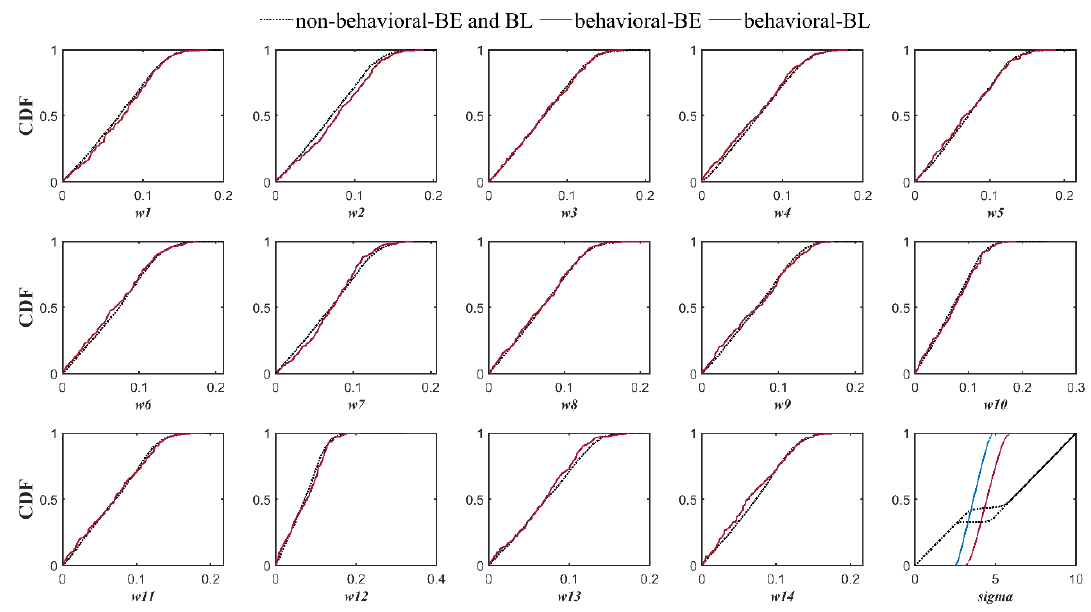
Figure 11. The regional sensitivity analysis (RSA) plots for the parameters of the C1V1T0 BMA variant for both the Big East River and Black River watersheds.